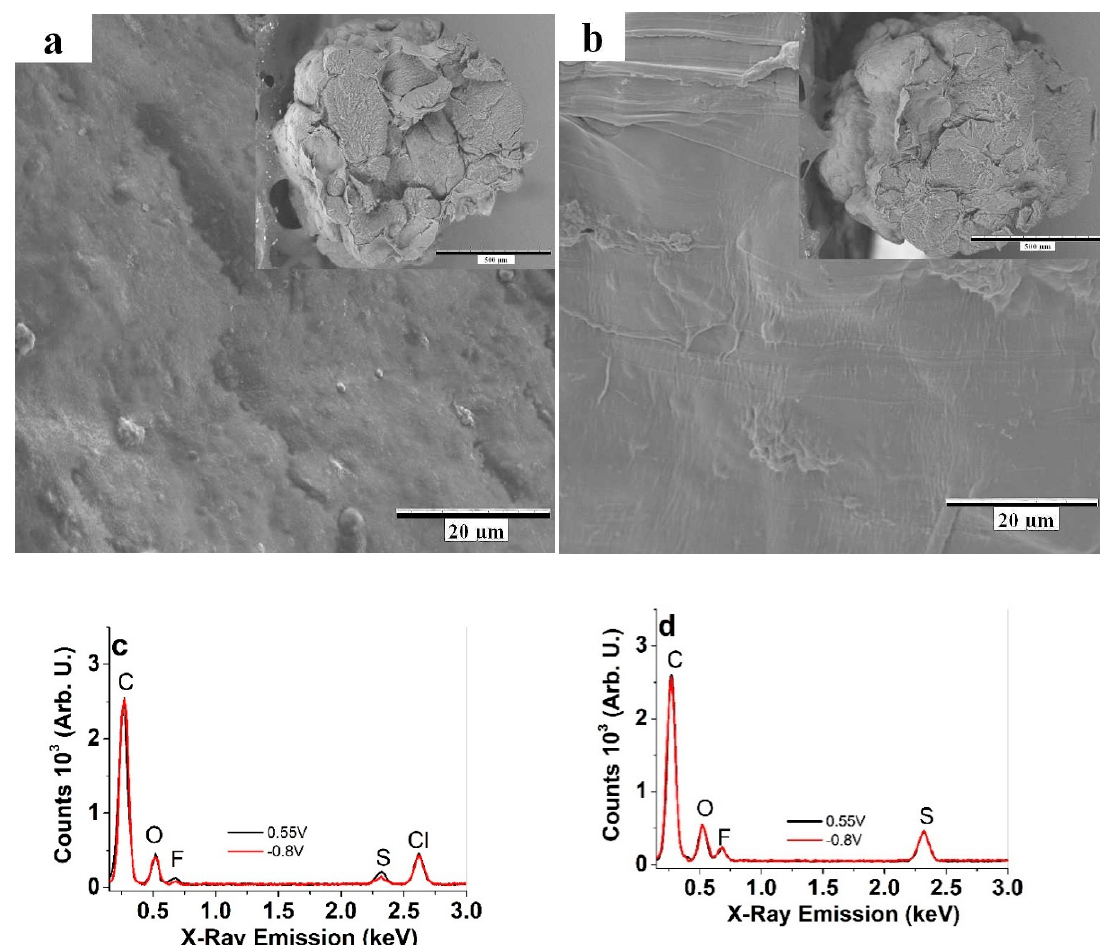
Figure 1. SEM images of the surface (scale bar 20 µ m) and cross section (inset, scale bar 500 µ m) of cellulose-multi wall carbon nanotube (Cell-CNT) fibers operated (200 actuation cycles) in ( a ) bis(trifluoromethane)sulfonimide lithium in propylene carbonate (LiTFSI-PC) and ( b ) LiTFSI in aqueous solvent (LiTFSI-aq). Energy dispersive X-Ray (EDX) spectra of Cell-CNT fibers in charged (0.55 V, black line) and discharged ( − 0.8 V, red line) state are presented in ( c ) for LiTFSI-PC and ( d ) for LiTFSI-aq electrolytes. (Li + ions are not detectable in EDX spectroscopy).